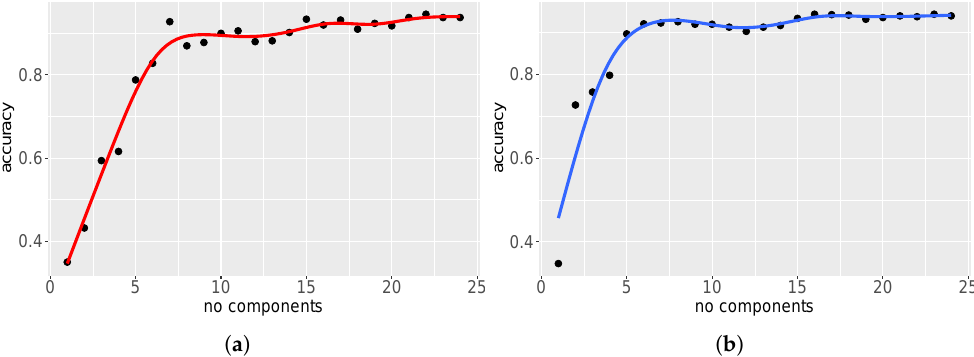
Figure 16. Observed changes in classification accuracy with the number of initial PCA components used, ( a ) LDA classifier, ( b ) RF classifier.